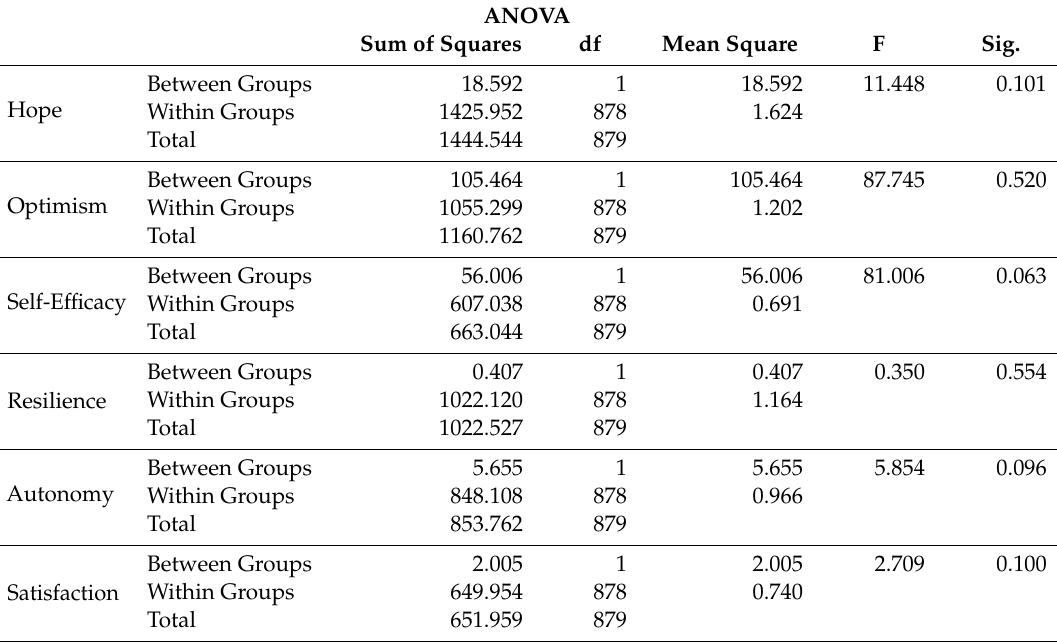
Table 3. Results of ANOVA test of di ff erence of variables between age groups. ANOVA Sum of Squares df Mean Square F Sig.